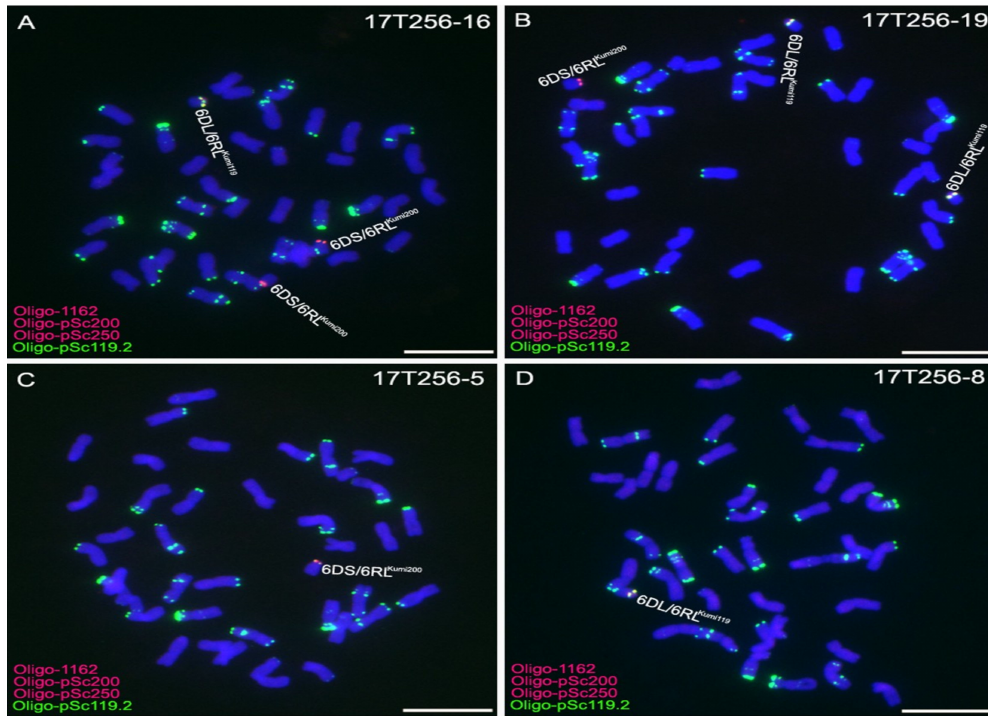
Figure 3. Oligo-pSc119.2-1 ( green ), Oligo-1162 ( red ), Oligo-pSc200 ( red ), and Oligo-pSc250 ( red ) were used as probes for ND-FISH analysis of the progeny of line 16T379-1. ( A ) Line 17T256-16 carried two 6DS/6RL Kumi200 chromosomes and one 6DL/6RL Kumi119 chromosome. ( B ) Line 17T256-19 carried one 6DS/6RL Kumi200 and two 6DL/6RL Kumi119 chromosomes. ( C ) Line 17T256-5 possessed only one 6DS/6RL Kumi200 chromosome. ( D ) Line 17T256-8 had only one 6DL/6RL Kumi119 chromosome. Chromosomes were counterstained with DAPI ( blue ). Scale bar 10 µ